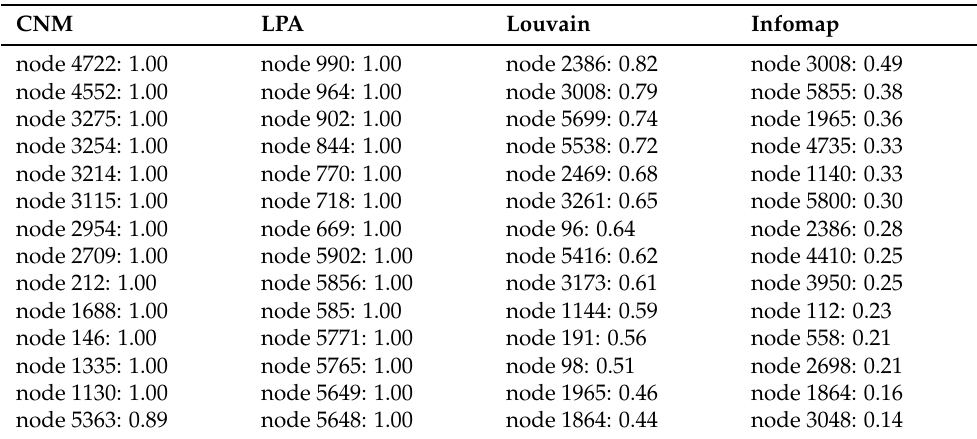
Table 6. Top hub-dominant nodes of the communities of Politician network (node: HD score).